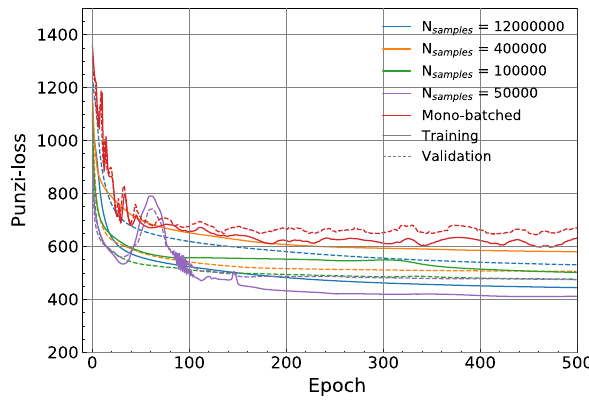
Fig. 2 Evolution of Punzi-loss during training with batch sizes of 5 × 10 4 , 1 × 10 5 , 4 × 10 5 and 1 . 2 × 10 6 and